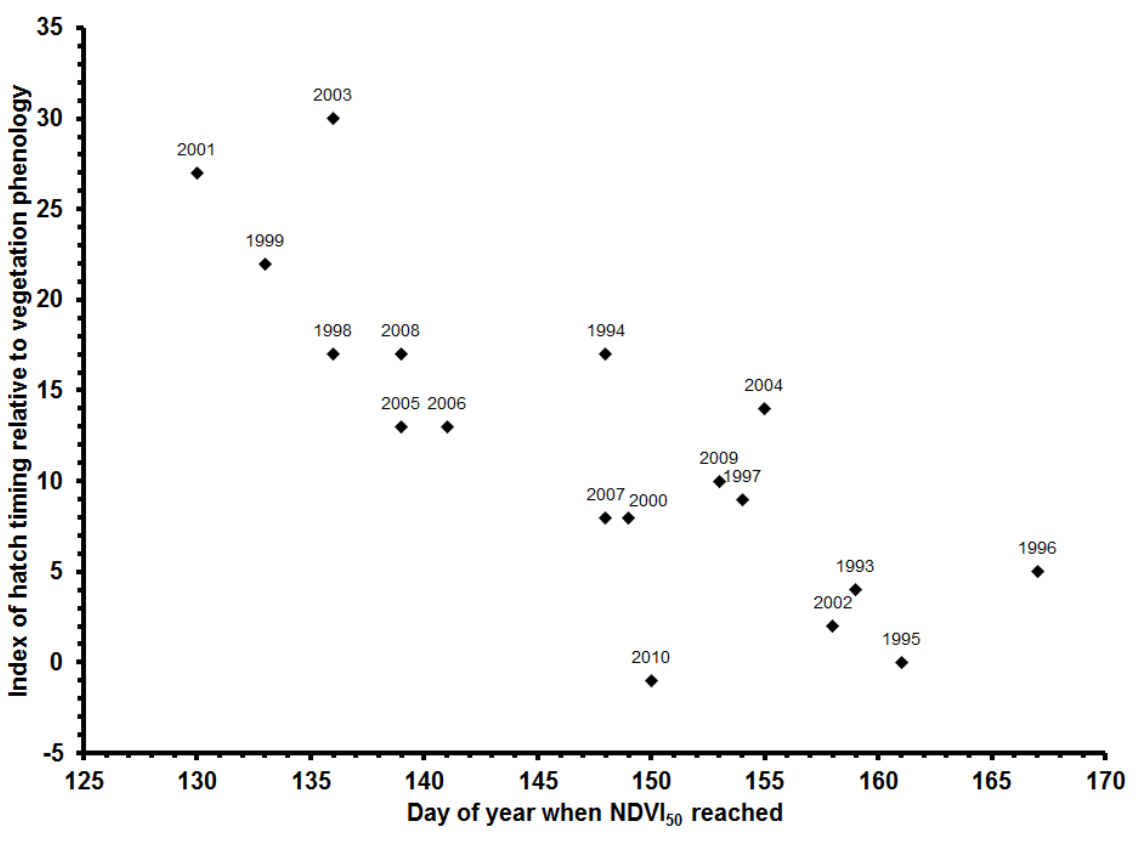
Fig. A2.1. Relationship between the day of year when the NDVI index of hatch timing relative to forage plant phenology for Canada geese on Akimiski Island, NU, from 1993 to